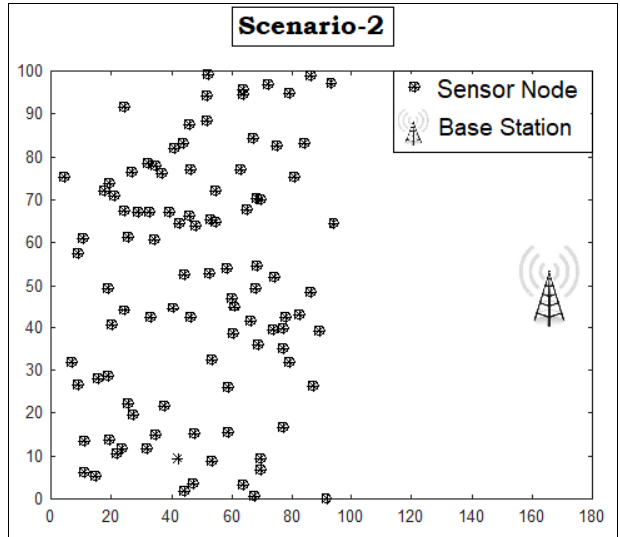
Figure 2. Network Layout-Scenario-2